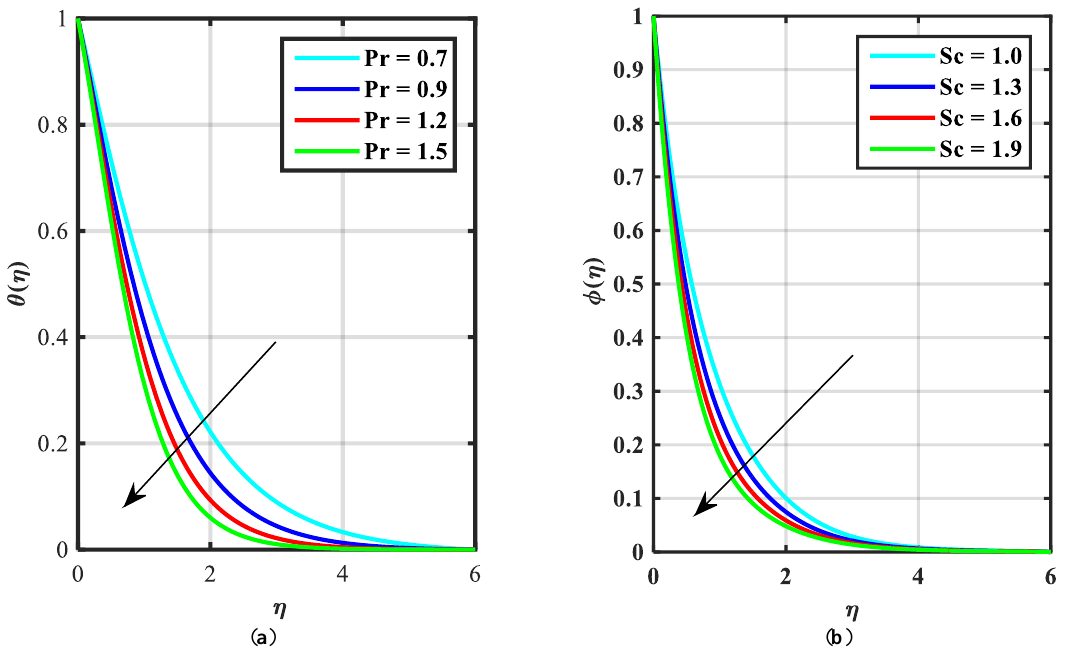
Figure 9. ( a , b ) Influence of 𝜃(𝜂) , 𝜙(𝜂) over Prandtl number 𝑃𝑟 and over Schmidt number 𝑆𝑐 .